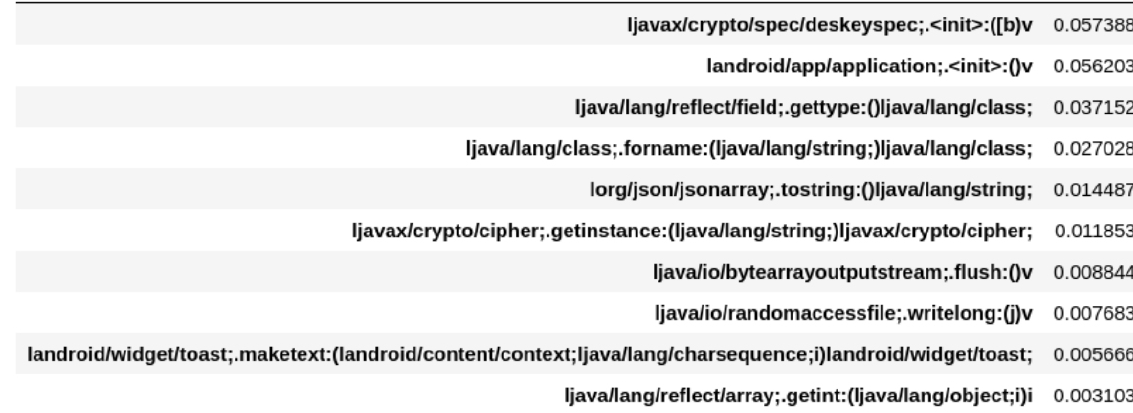
Figure 8. API-calls and attention weights for an Android malware app